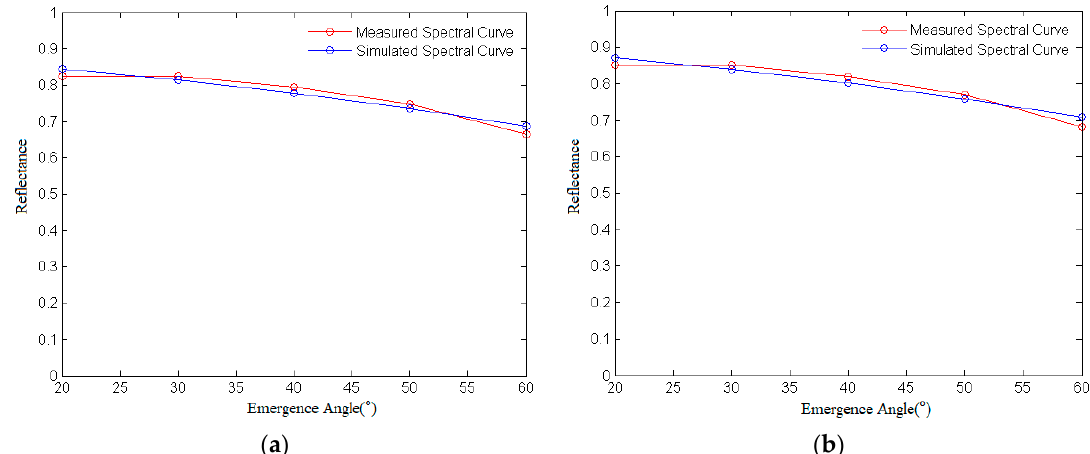
Figure 16. ( a , b ) Comparison of the simulated and measured spectra of plagioclase at some characteristic wavelengths as a function of angle.